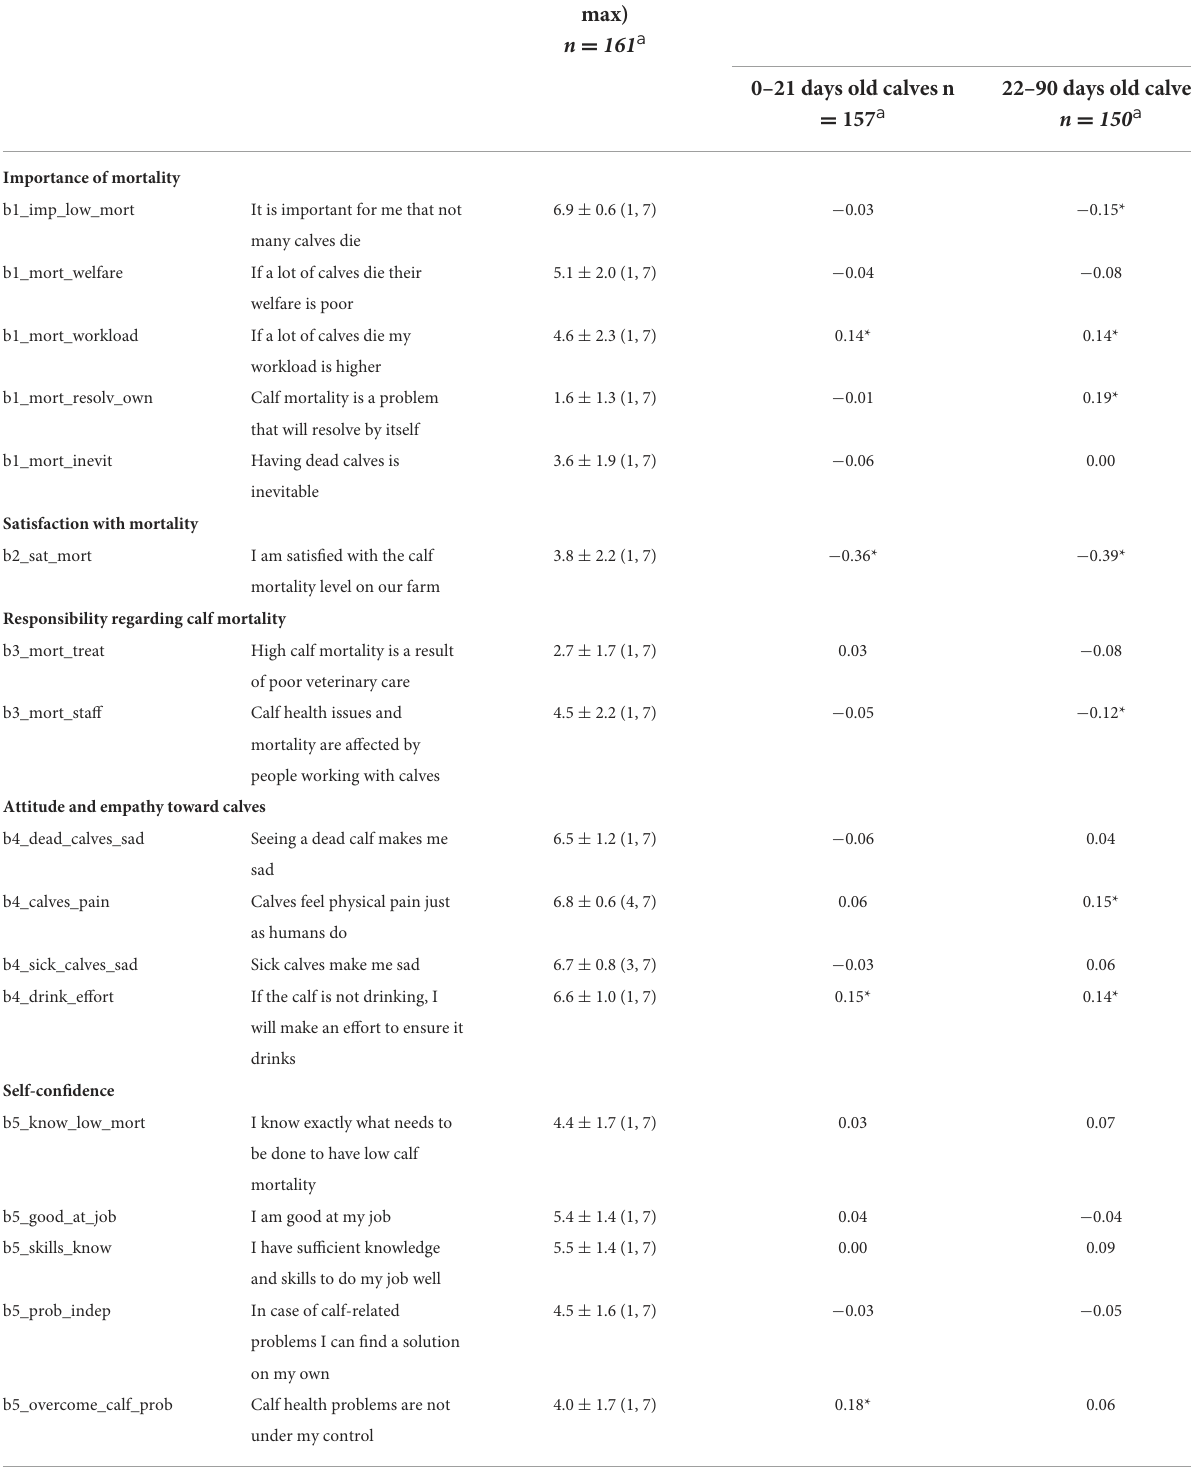
TABLE 1 Statements reflecting calf care workers’ attitudes and opinions, personality characteristics and satisfaction with work-related factors evaluated in a 7-point Likert scale and Spearman correlation coefficients with calf mortality in two age groups. Block / variable